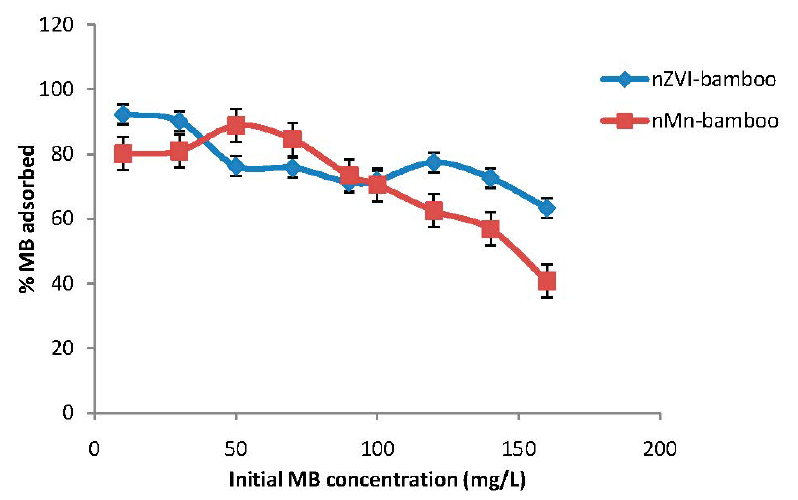
Figure 2. Effect of initial methylene blue (MB) concentration ( wt = 0.02 g, pH = 5, T = 32 ± 2 °C for 2 h at 165